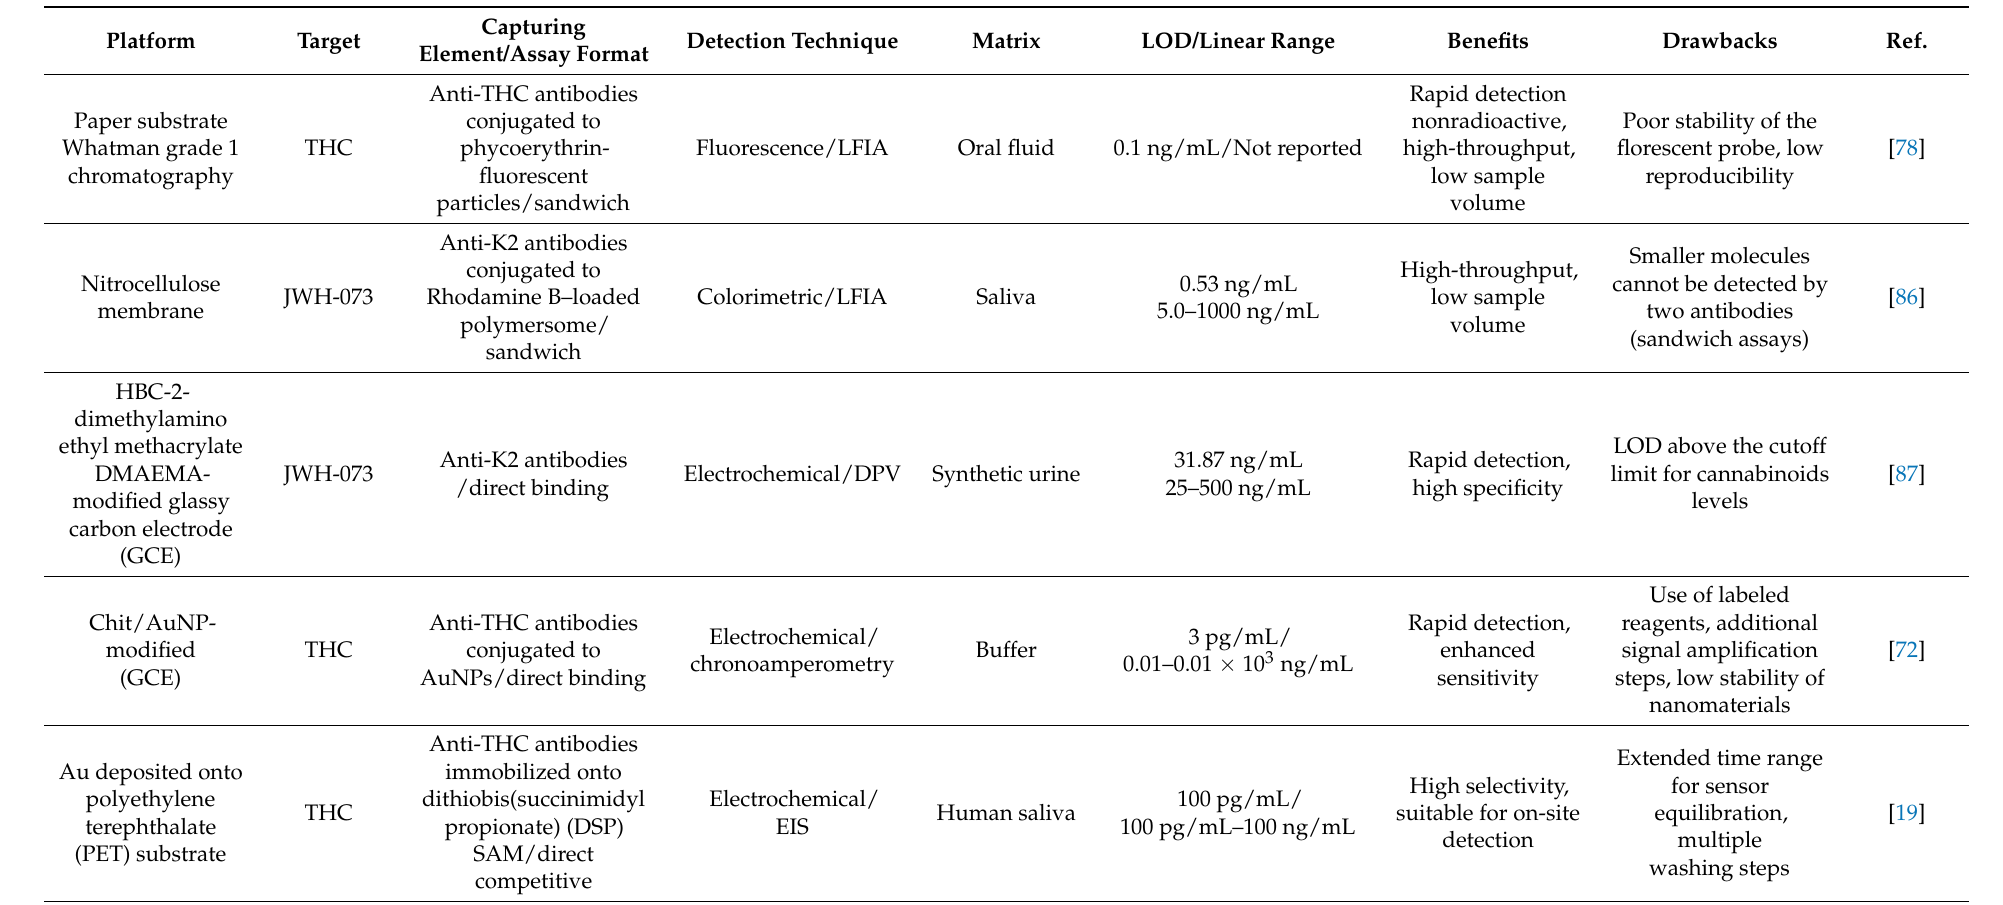
Table 2. Relevant biosensors for cannabinoids’